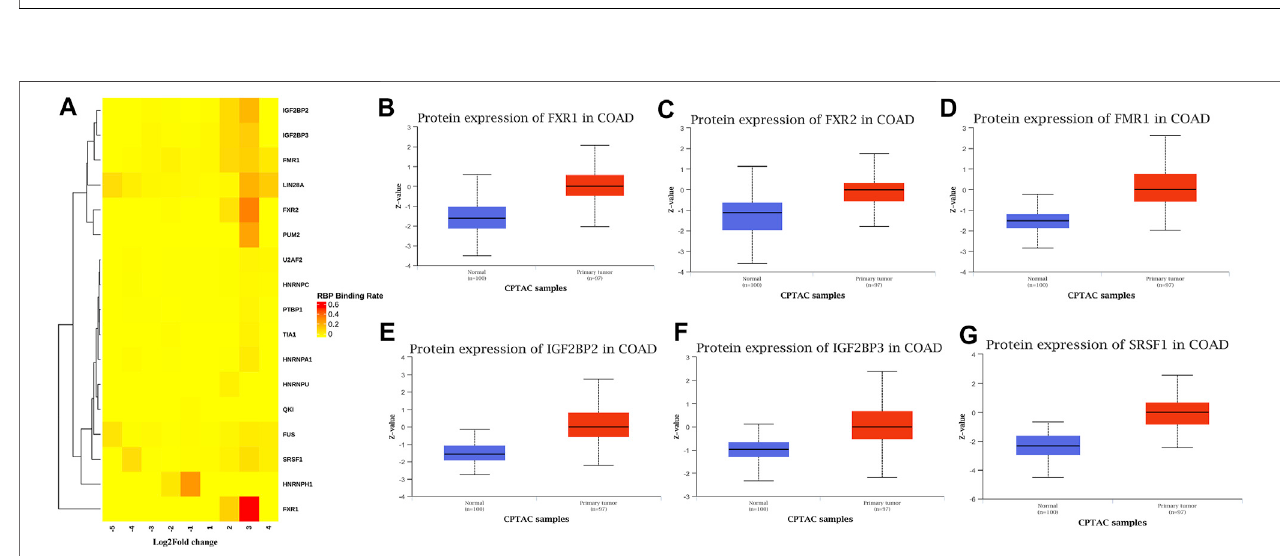
FIGURE 7 | RNA binding protein based on differential methylation and expression gene prediction. (A) The heatmap showing 17 RBPs of differentially methylated andexpressedgenes(columns:theratioofdifferentiallymethylatedareasofCRC/NC;rows:RBPs). (B – G) ExpressionofFXR1/FXR2/FMR1/IGF2BP2/IGF2BP3/SRSF1 in normal tissues and primary COAD tissues based on CPTAC database. (Z-values represent standard deviations from the median across samples for COAD).